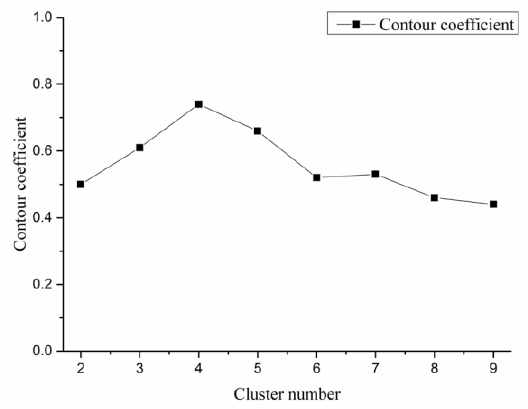
Figure 3. The curve of cluster number and contour coe ffi cient.